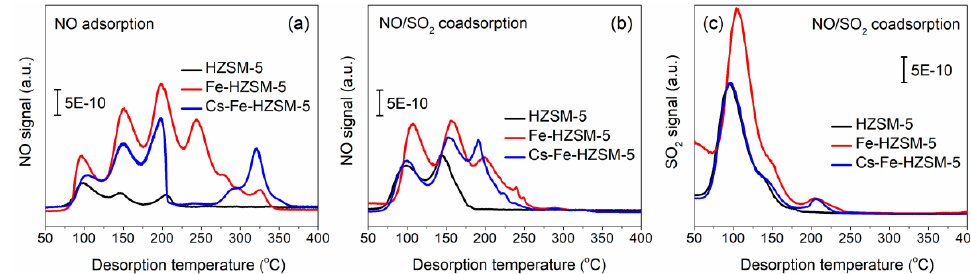
Figure 10. NO and SO 2 TPD profiles of Fe-HZSM-5 and Cs-Fe-HZSM-5: ( a ) NO desorption profiles after NO adsorption; ( b ) NO desorption profiles after NO/SO 2 coadsorption; ( c ) SO 2 desorption profiles after NO/SO 2 coadsorption. 5000 ppm NO with N 2 as balance gas for NO adsorption, 5000 ppm NO, 2500 ppm SO 2 with N 2 as balance gas for NO/SO 2